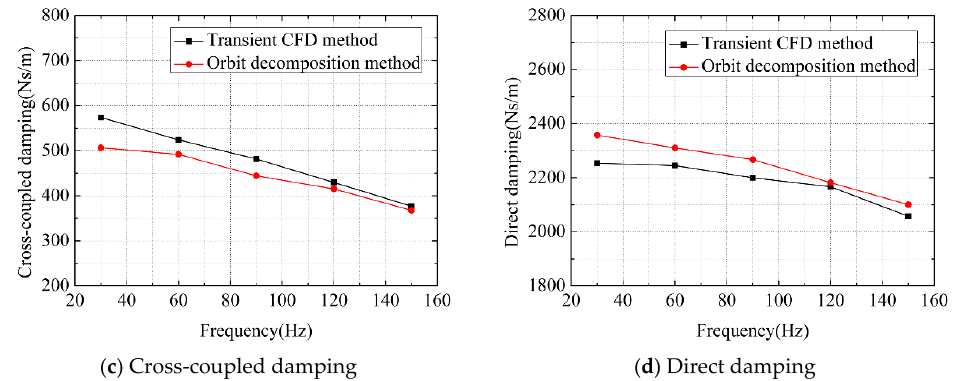
Figure 14. Comparison of rotordynamic coefficients.